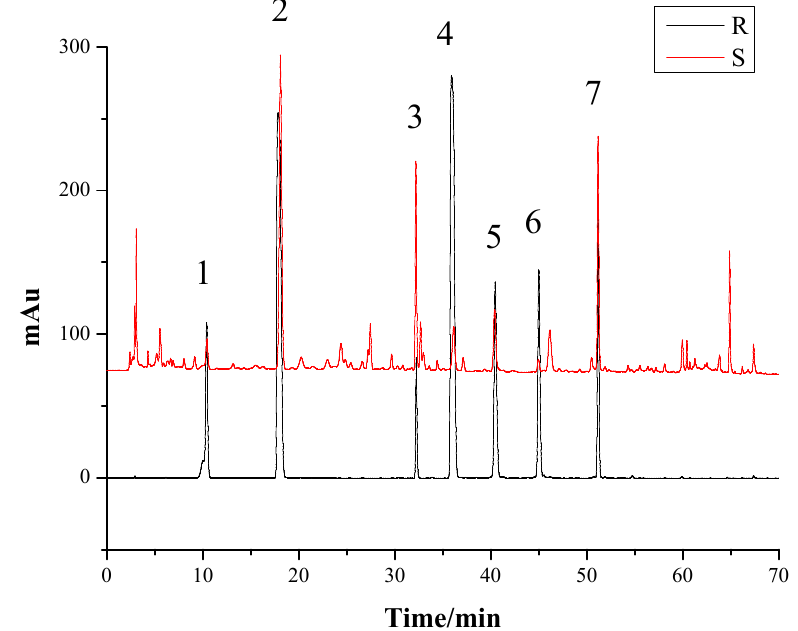
Figure 1. The HPLC fingerprints of the Gastrodia elata tuber sample and the mixed standards. R: The mixed standards; S: The G. elata tuber sample. 1—Gastrodin; 2— p -Hydroxy benzyl alcohol;